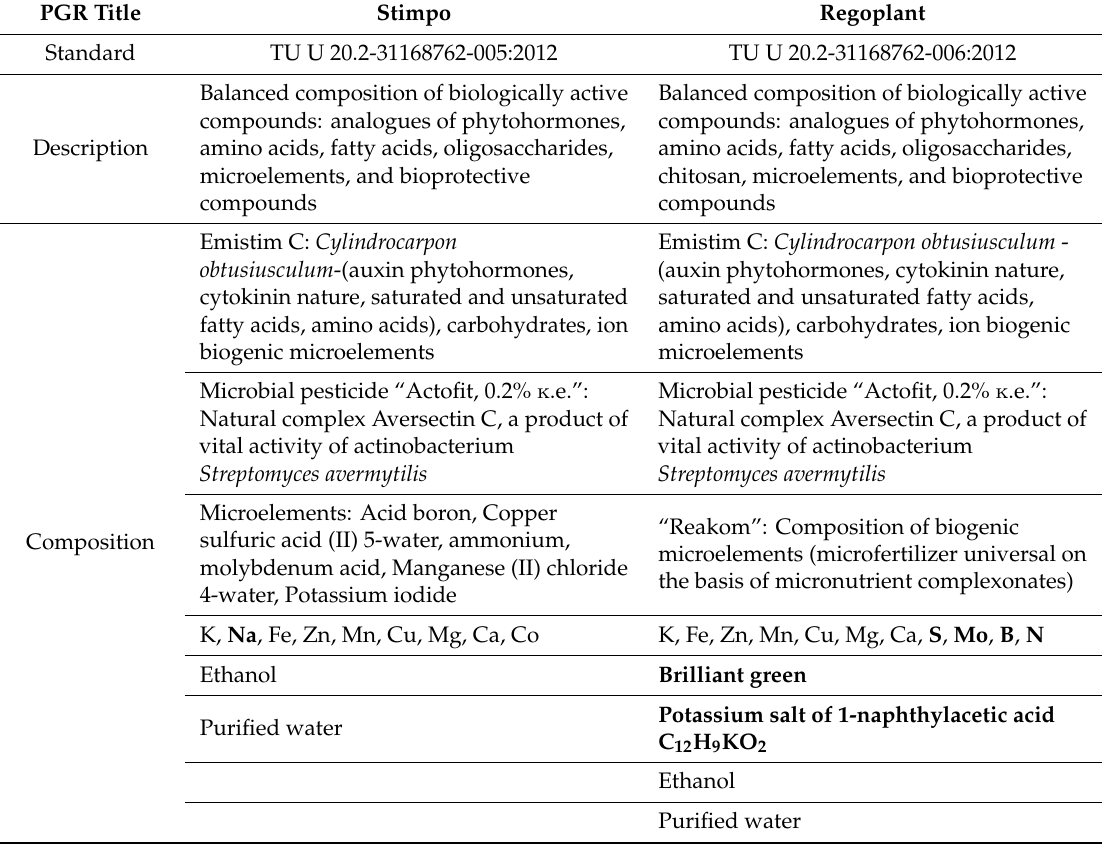
Table 2. Composition of used plant growth regulators (PGRs) (adapted from Nebesk á et al. [19] and http: // www.agrobiotech.com.ua), components which are specific for sole PGR are in bold.